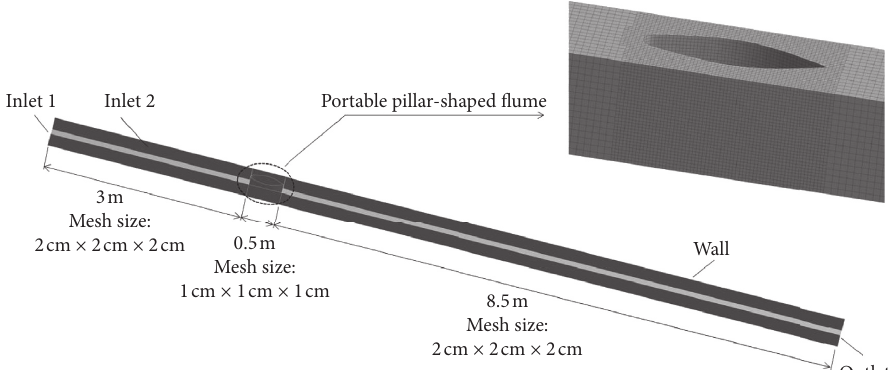
Figure 4: Model and boundary conditions of the portable pillar-shaped